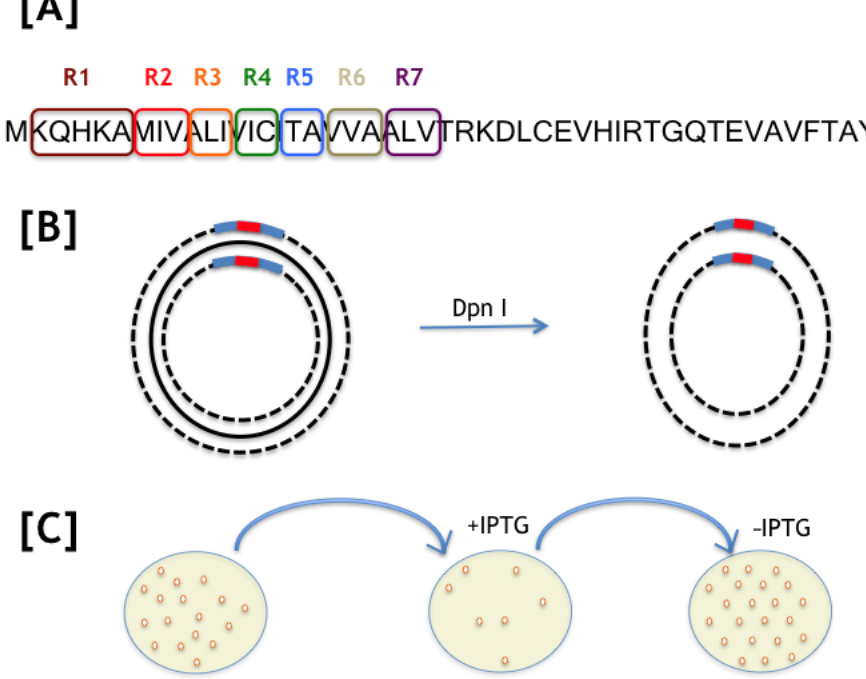
Figure 1. Mutagenesis strategy. ( A ) Seven regions were selected to mutate the ORF coding for HokC; the full sequence of HokC is shown and the regions are marked. ( B ) Oligonucleotides (blue bars) were designed to introduce mutants (red bars) using a QuickChange strategy; the plasmid harboring the wild-type sequence for HokC was amplified (indicated by a punctuated line) and the original plasmid was eliminated by digestion with Dpn I (see Methods for details). ( C ) The plasmids harboring the desired mutations were transferred to competent E. coli cells and each colony obtained was replicated into two plates, one with (+IPTG) and another without IPTG ( − IPTG), the inducer of HokC expression; cells growing in IPTG harbor a mutation that inactivated the HokC activity and those not growing harbored a mutation that did not affect HokC activity.